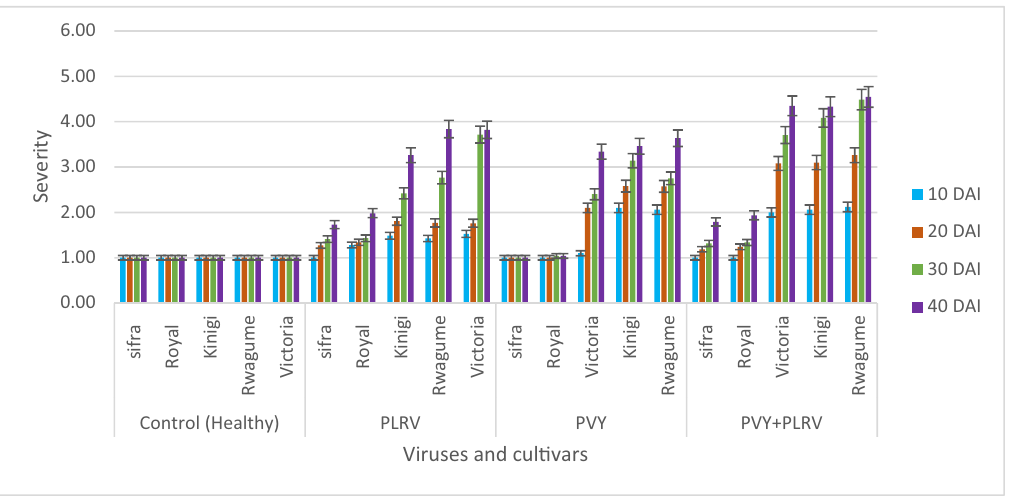
Figure 2: Virus disease severity among the fi ve varieties infected with PVY, PLRV and PVY + PLRV. DAI = days after